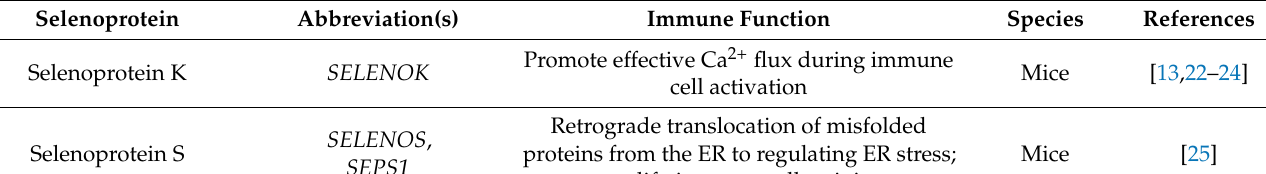
Table 1. Immune function of related